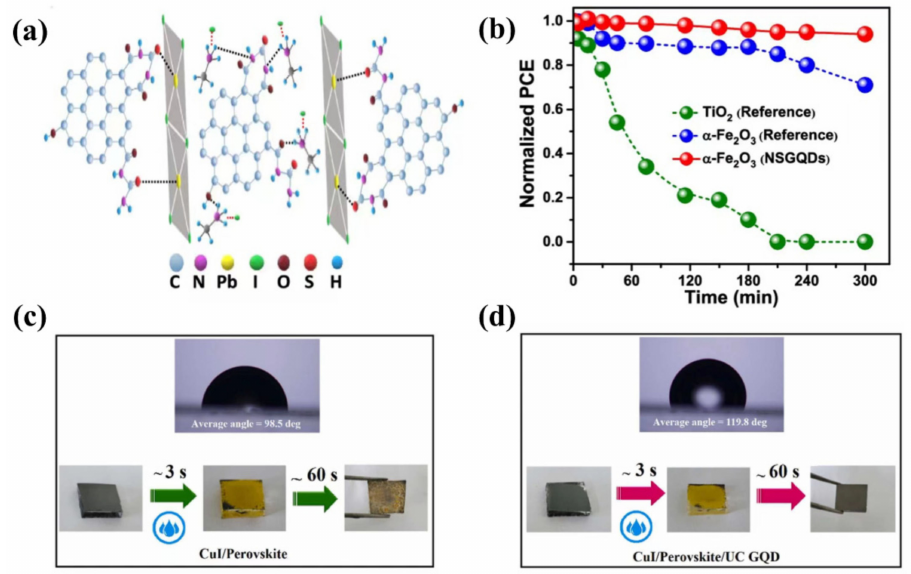
Figure 4. ( a ) Schematic representation of the interaction between PbI 2 -MAI and NSGQDs. Repro- duced from [78], with permission from American Chemical Society, 2020. ( b ) Normalized PCE decay of perovskite devices based on different ETLs as a function of UV irradiation time at an in- tensity of 500 mW cm − 2 . Reproduced from [78], with permission from American Chemical Society, 2020. ( c , d ) CuI/Perovskite and CuI/Perovskite/UC GQD films. Optical images of the perovskite films (without encapsulation) as a function of humidity exposure time in 90 ± 5% RH. Reproduced from [80], with permission from Elsevier,